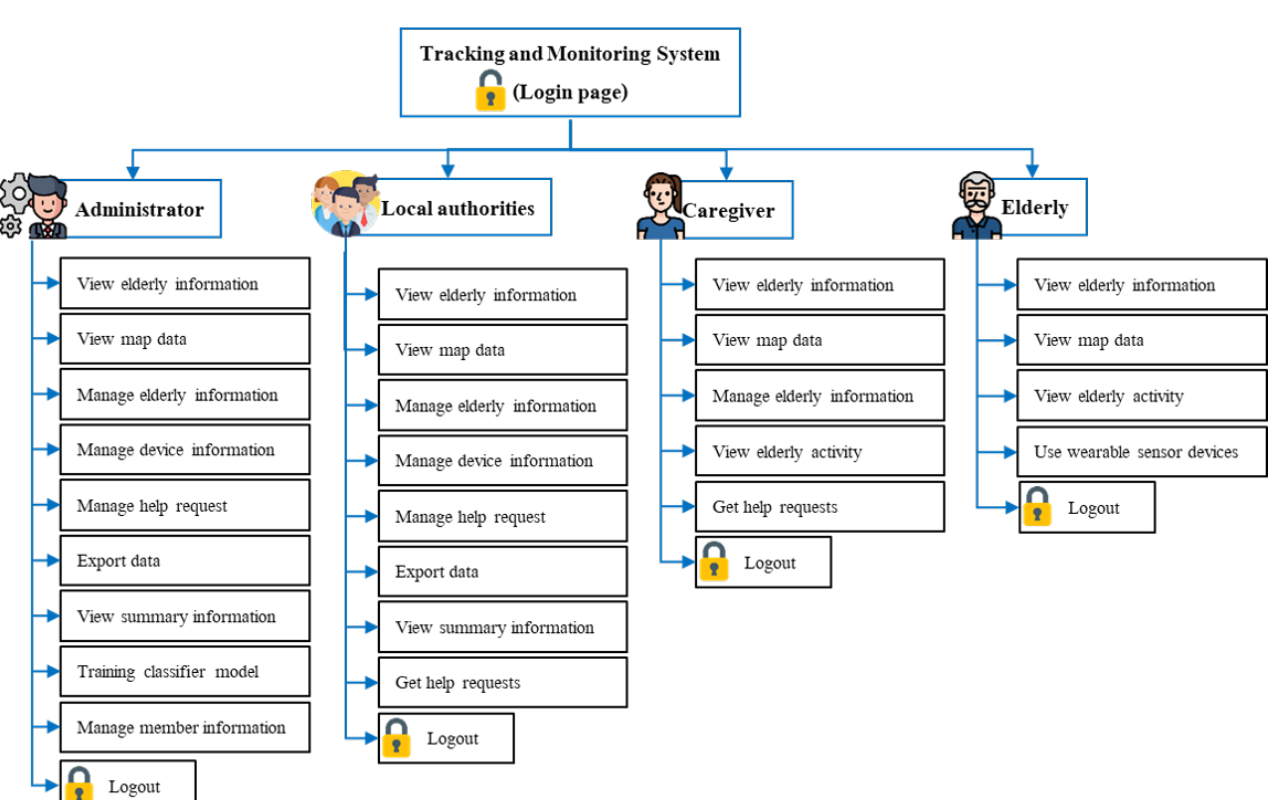
Figure 6. The interface structure design of the